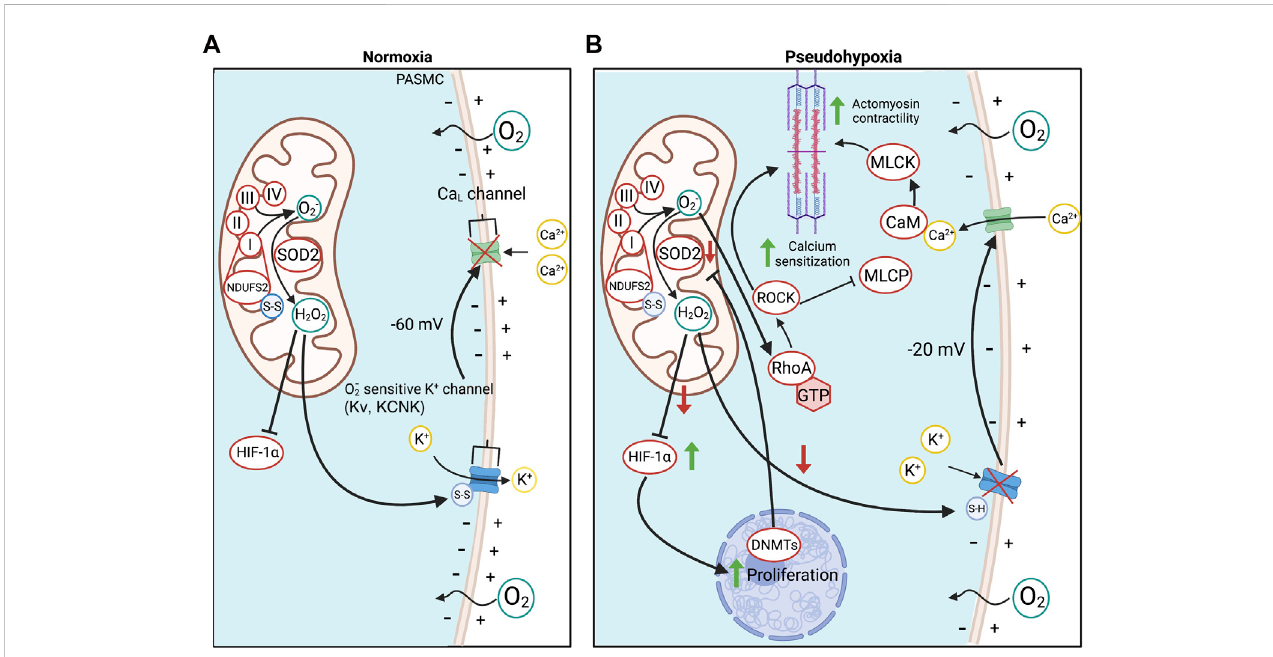
FIGURE 2 OxygensensinginPASMCinhealthandPAH. (A) .O 2 detectioninPASMCisenabledbytheredox-sensitiveNDUFS2inETCComplexI.NDUFS2generates ROS during normoxia, creating a relatively oxidized state, whilst in hypoxia, NDUFS2 produces fewer radicals, creating a state of reduction. During normoxia, disul fi de bridges in NDUFS2 are oxidized in support of ROS production and SOD2 converts O 2 − to diffusible H 2 O 2 for cytosolic export. H 2 O 2 oxidizes redox- sensitive, voltage-gated, K + channels, increasing their open state probability and maintaining tonic K + egression, thereby hyperpolarizing the PASMC membrane potential and inactivating voltage-dependent calcium channels. This favours a state of normoxic relaxation. (B) . Epigenetic methylation of the SOD2 gene in PAH by DNMTs reduces SOD2 expression and decreases normoxic production of H 2 O 2. The resulting reduced redox state chemically reduces K + channel disul fi de bridges, inhibiting K + channel opening and depolarizing the PASMC. As a result, voltage-dependent L-type Ca 2+ channels (Ca L ) are activated, increasingcytoplasmicCa 2+ whichleads to vasoconstriction.Changesinredox state andcytosoliccalcium also inducecalcium/calmodulin(CaM)- dependent activation of myosin light chain kinase (MLCK), which creates a more sustained form of vasoconstriction. O 2 − also activates ROCK through